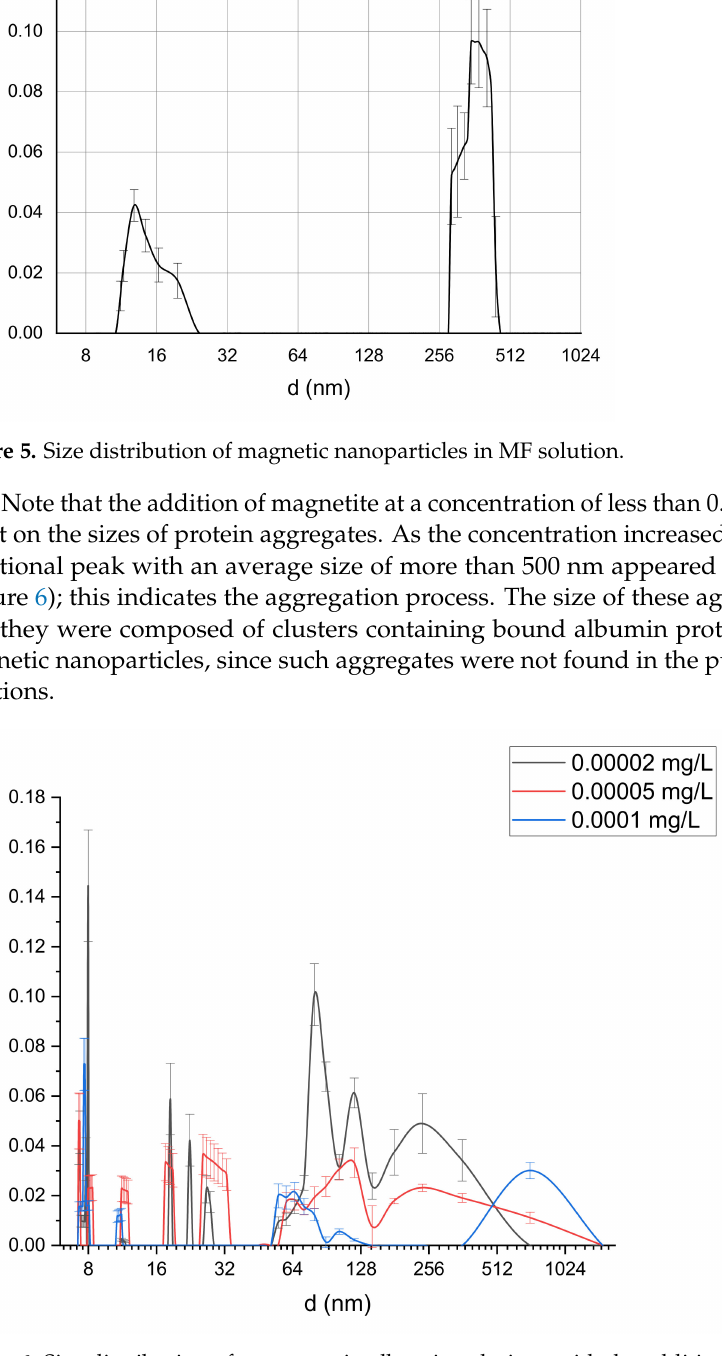
Figure 6. Size distribution of structures in albumin solutions with the addition of magnetic fluid at low